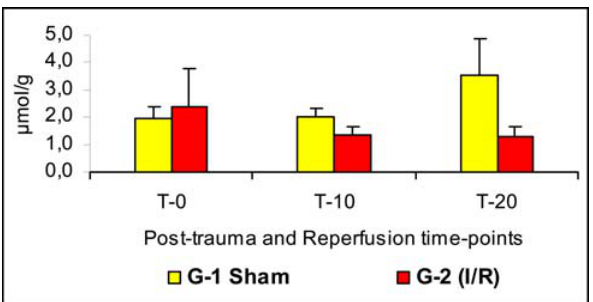
FIGURE 3 - Spinal cord glucose concentrations (n=6) in G- 1 and G-2 groups tissue homogenates. Values are expressed as